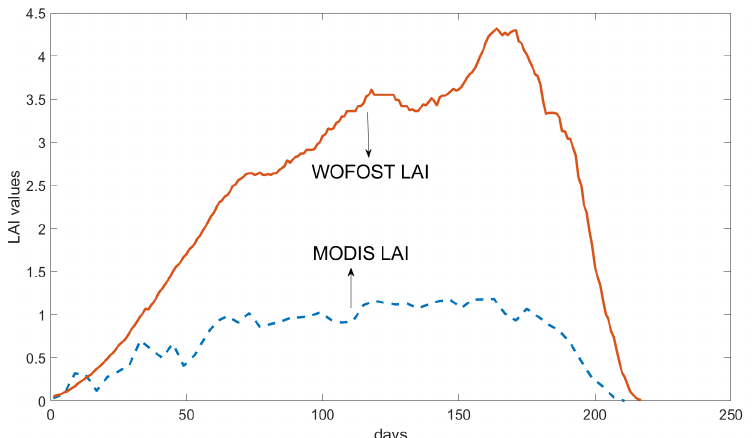
Figure 4. Oilseed rape field near the meteorological station in Jingzhou city predicted with the finely localized WOFOST model. The cultivated days started on 1 October 2014, and ended on 5 May